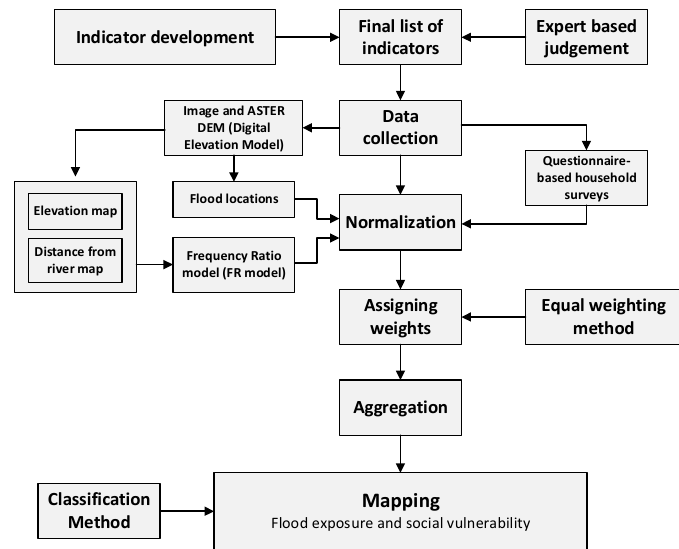
Figure 5. Flow chart and methodological process.